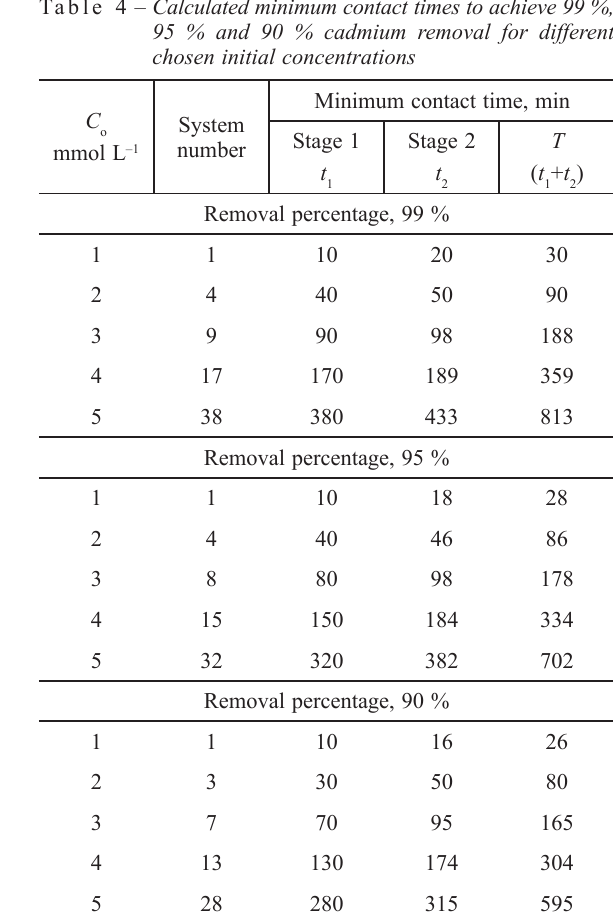
Table 3 – Calculated minimum contact times to achieve 99 %, 95 % and 90 % zinc removal for different chosen